Question: Briefly state, in one sentence, what is plotted here.
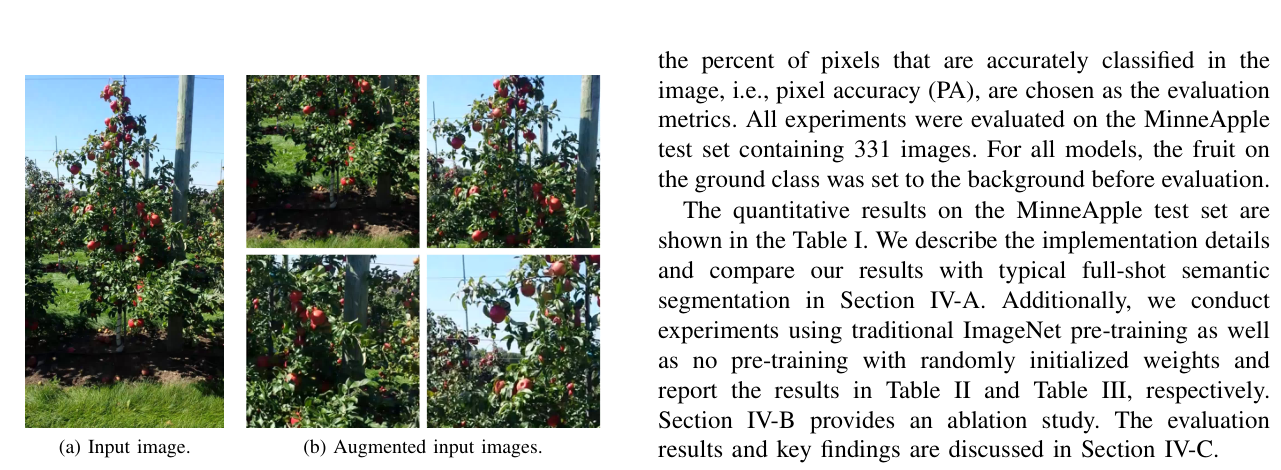
Answer: A visualization of the data augmentation used for few-shot semantic segmentation of in-orchard apples. The original image is shown in (a) and the resulting augmented image crops are shown in (b). Each panel in (b) displays a random crop of the scale used where the top left is scaled by 0.75, top right by 1.0, bottom left by 1.25, and bottom right by 1.5.